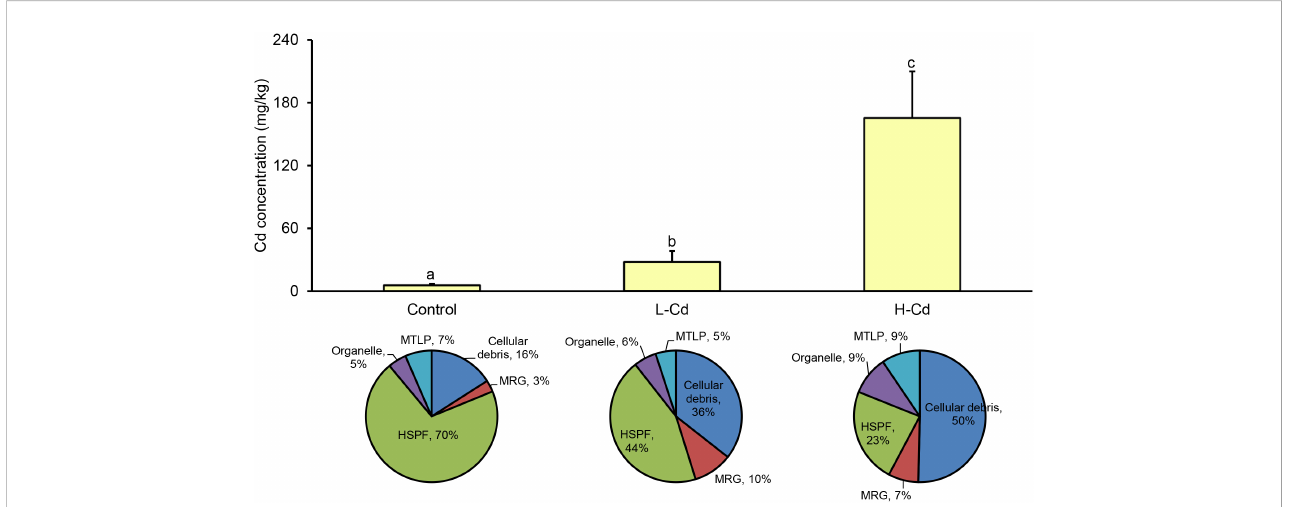
FIGURE 1 Mean metal concentrations (mg/kg) and subcellular distribution of Cd in gills of the deep-sea mussel Gigantidas platifrons after 7 days of exposure to 100 or 1000 m g/L Cd (n = 10 per group, mean ± SD). Values followed by the same letter are not statistically different ( P > 0.05) between the treatment groups. Pie charts show subcellular distribution of Cd in the gills of G. platifrons. L-Cd: 100 m g/L Cd; H-Cd: 1000 m g/L Cd; MTLP: metallothionein-like protein; MRG: metal-rich granules; HSPF: heat-sensitive